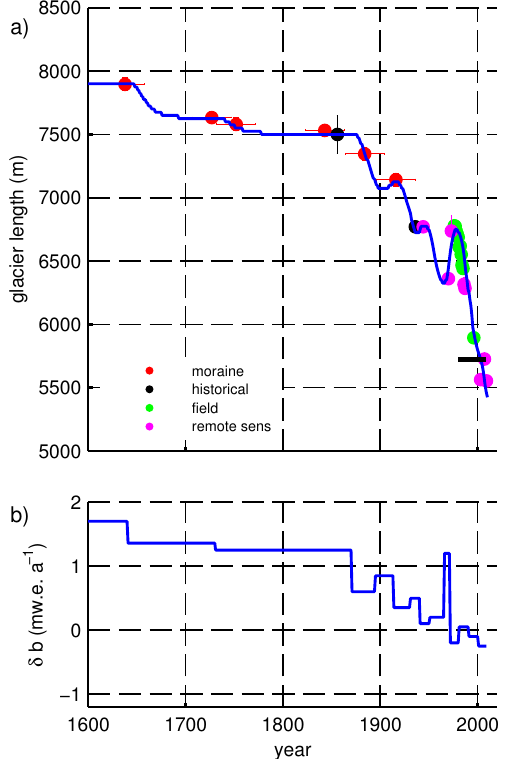
Fig. 10. (a) Observed glacier length of Fr´ıas (dots); colours indi- cate the type of observation (cf. Table 1); bars indicate the uncer- tainty in both time (dated moraines) and length (most of the times smaller than the dots); modelled equilibrium length for the 1980– 2009 climate (horizontal black line); and modelled glacier length reconstructed with dynamical calibration (blue). (b) Mass balance perturbations δb that reproduce the observed glacier